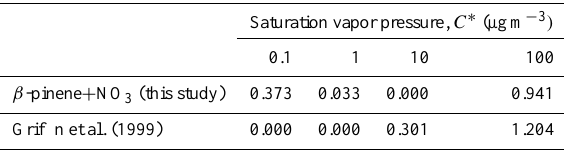
Table 3. Coefficients for the volatility basis set proposed by Don- ahue et al.